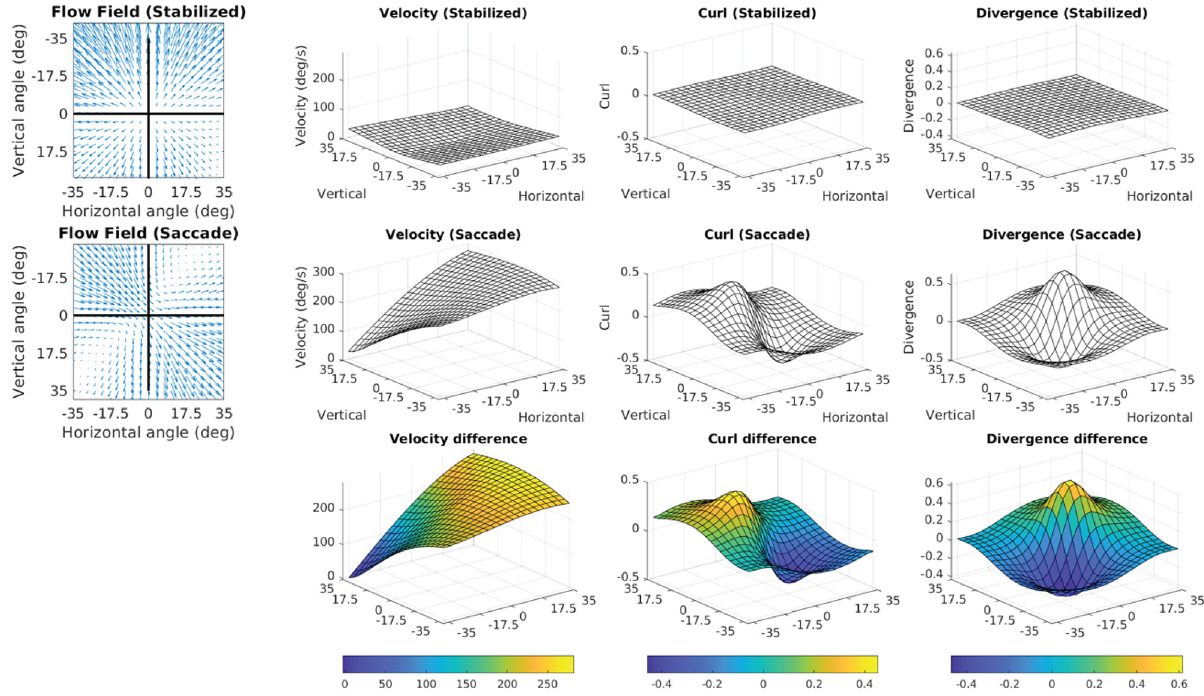
Fig 10. Comparison of representative flow field during stabilization versus during a saccade (195 deg/s up and to the left). The top row shows retinal motion while the eye is fixating and the second row shows motion during a saccade. The bottom row shows the difference for velocity, curl, and divergence plots between the motion during a fixation and motion during a saccade (that is, between the top and middle rows. The flow fields on the left show that when gaze is stable, motion is outwards, away from fixated location. During the saccade, flow is strongly influenced by the direction of the saccade (motion in the opposite direction is added). On the right side of the Figure, velocities are low with 0 deg/s at the fovea when gaze is stabilized. By contrast the saccade results in speed at the fovea equal to the speed of saccade (195 deg/s), with velocities at all other retinal locations increased by more than an order of magnitude. The saccade also results in increase in curl values by more than order of magnitude and alters the spatial structure of curl pattern. Similar to effect on curl values, divergence values change by order of magnitude, and spatial structure is altered. Note that the scale of the difference plot in the bottom row differs by a factor of over 10 in Fig